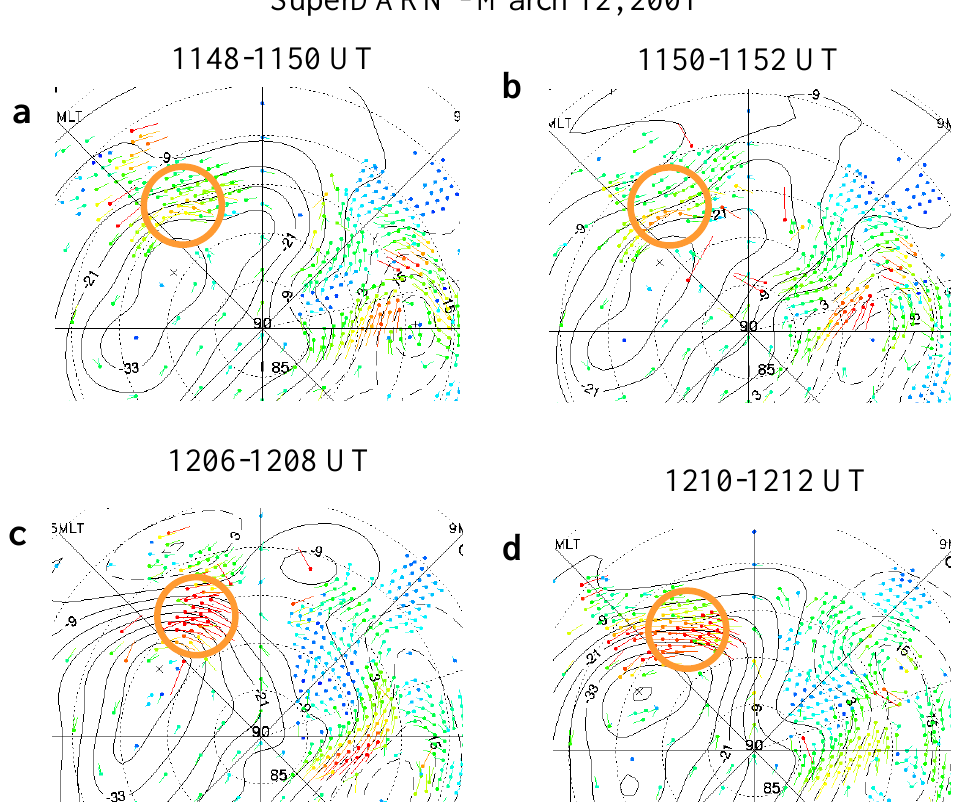
Fig. 16. Potential patterns and drift vectors determined from SuperDARN measurements for 4 intervals related to merging observations at Polar and Cluster. The regions of interest are highlighted by the orange